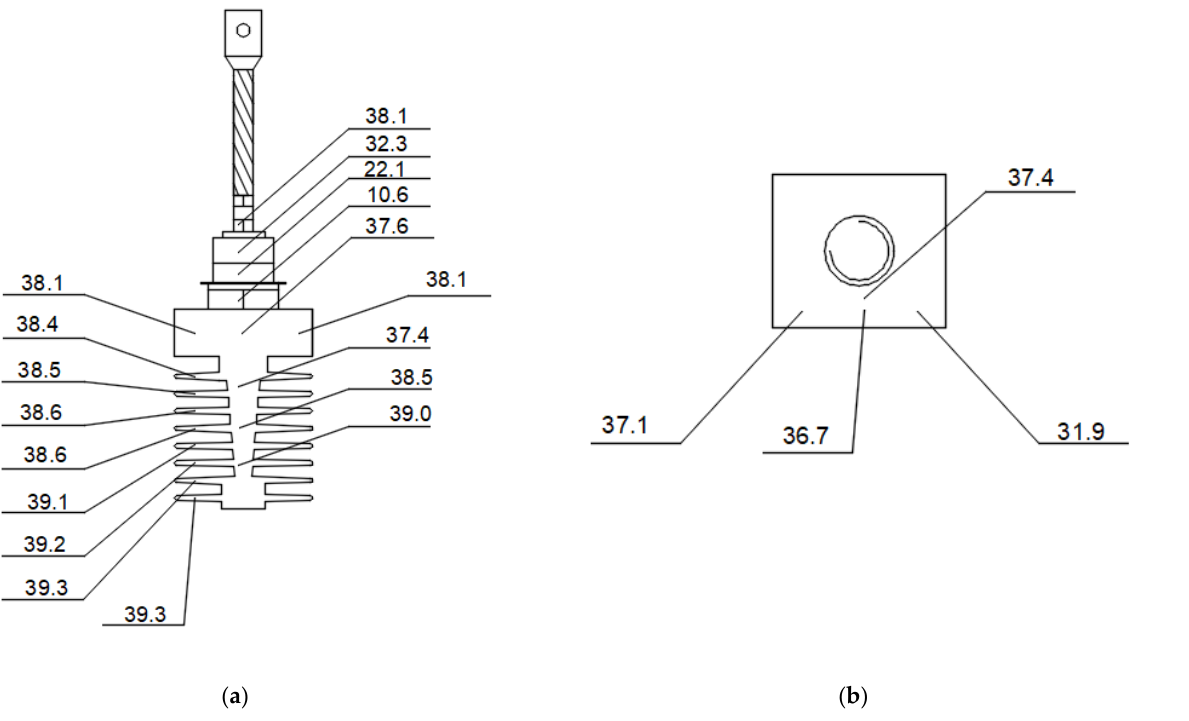
Figure 20. Differences ( T j – T s ) between the junction temperature ( T j ) and the surface temperatures ( T S ) (from Tables 6 and 7) at points presented in Figure 2 for a power of P j = 74.36 W: ( a ) side view; ( b ) top view.